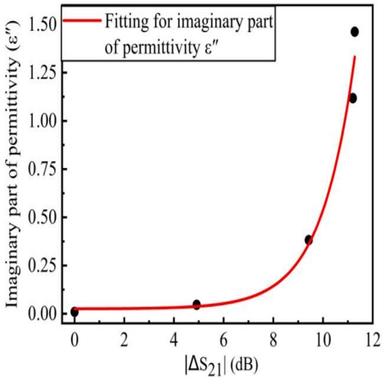
Fitting for the imaginary part of permittivity (ε″ r).